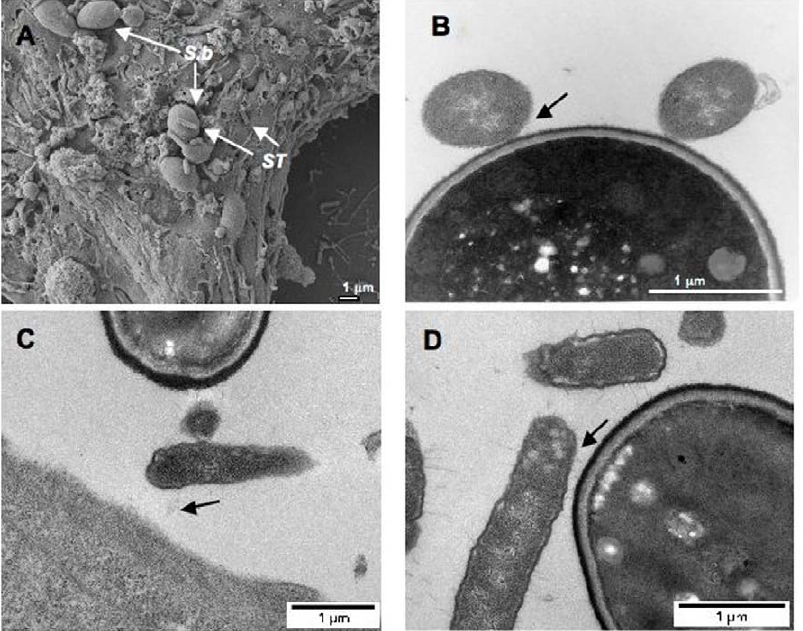
Figure 5. Binding of S. Typhimurium (ST) to S.boulardii (Sb) cell wall. (A) Scanning electron micrograph of T84 cells infected by ST in the presence of Sb. (B) Transmission electron microscopy. (C, D) Transmission electron micrograph after red ruthenium staining. N=3. Black arrows show the binding of bacteria to the yeast.